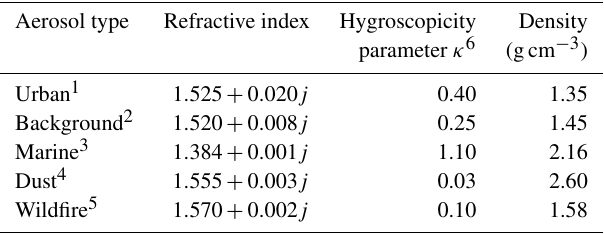
Table 2. Aerosol optical and chemical properties used in this